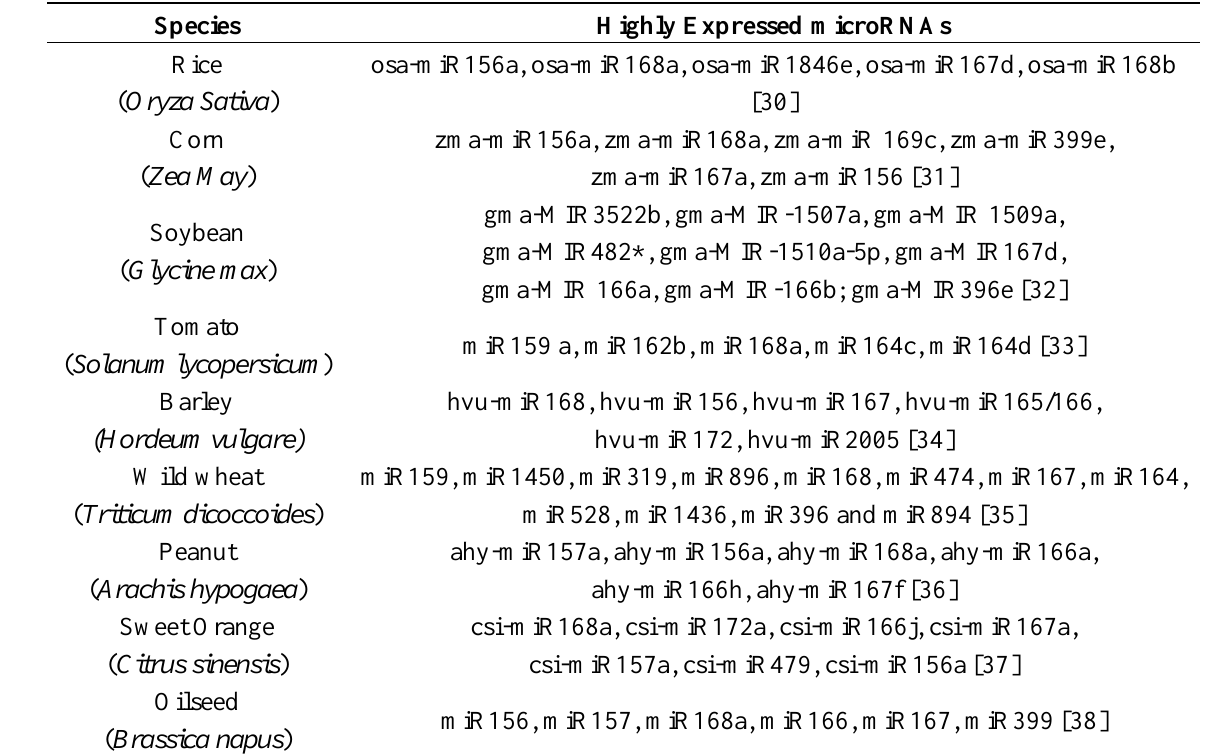
Table 1. Highly-expressed dietary miRNAs from various crops, fruits,